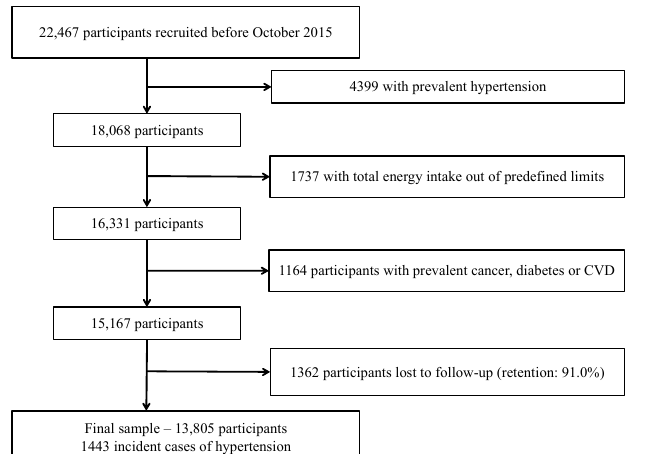
Figure 1. Flow-chart of participants. The “Seguimiento Universidad de Navarra” (SUN) cohort (1999–2018).